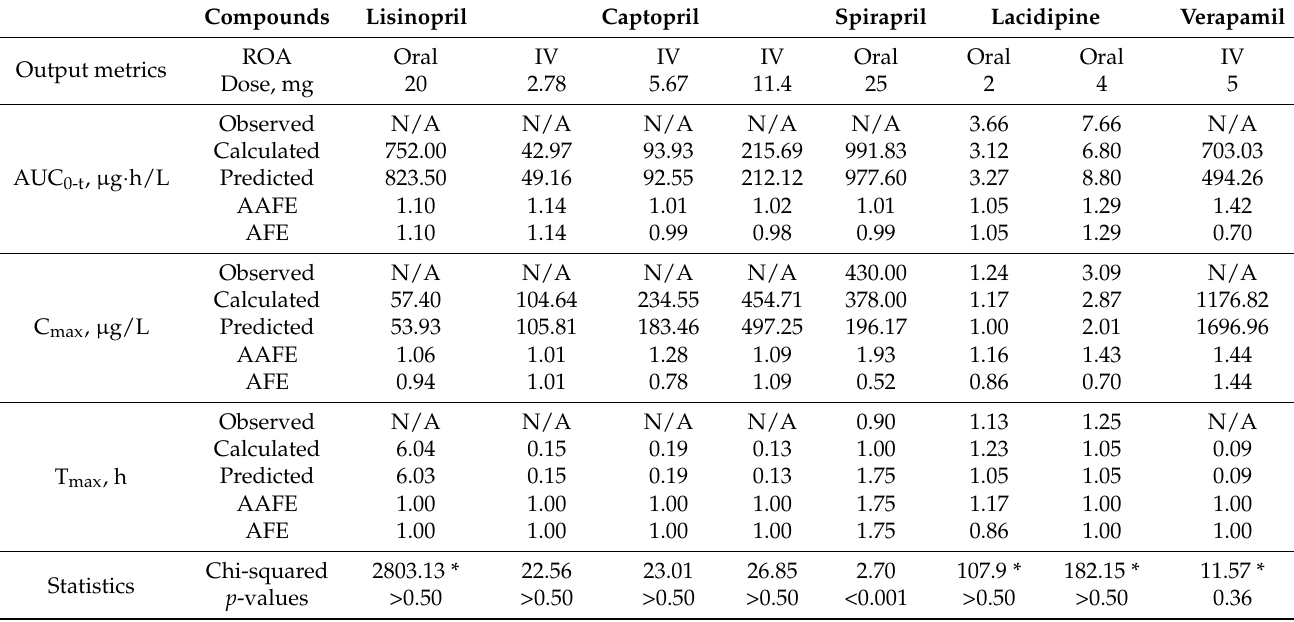
Table 4. Comparison of plasma venous PK metrics between model simulation outputs and experimentally-derived